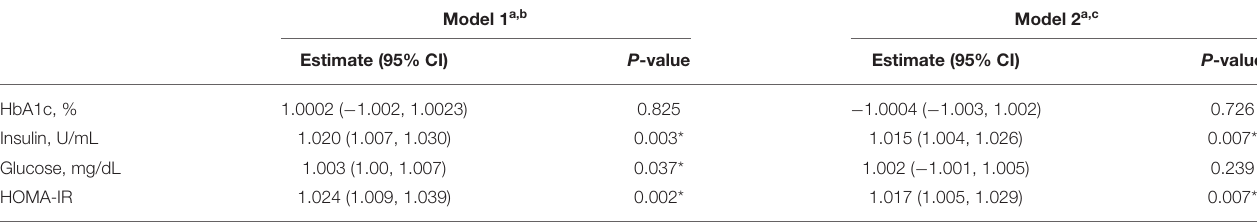
TABLE 2 | Associations between whole blood selenium concentration and glucose and insulin markers in US adults from NHANES 2013 to 2018.